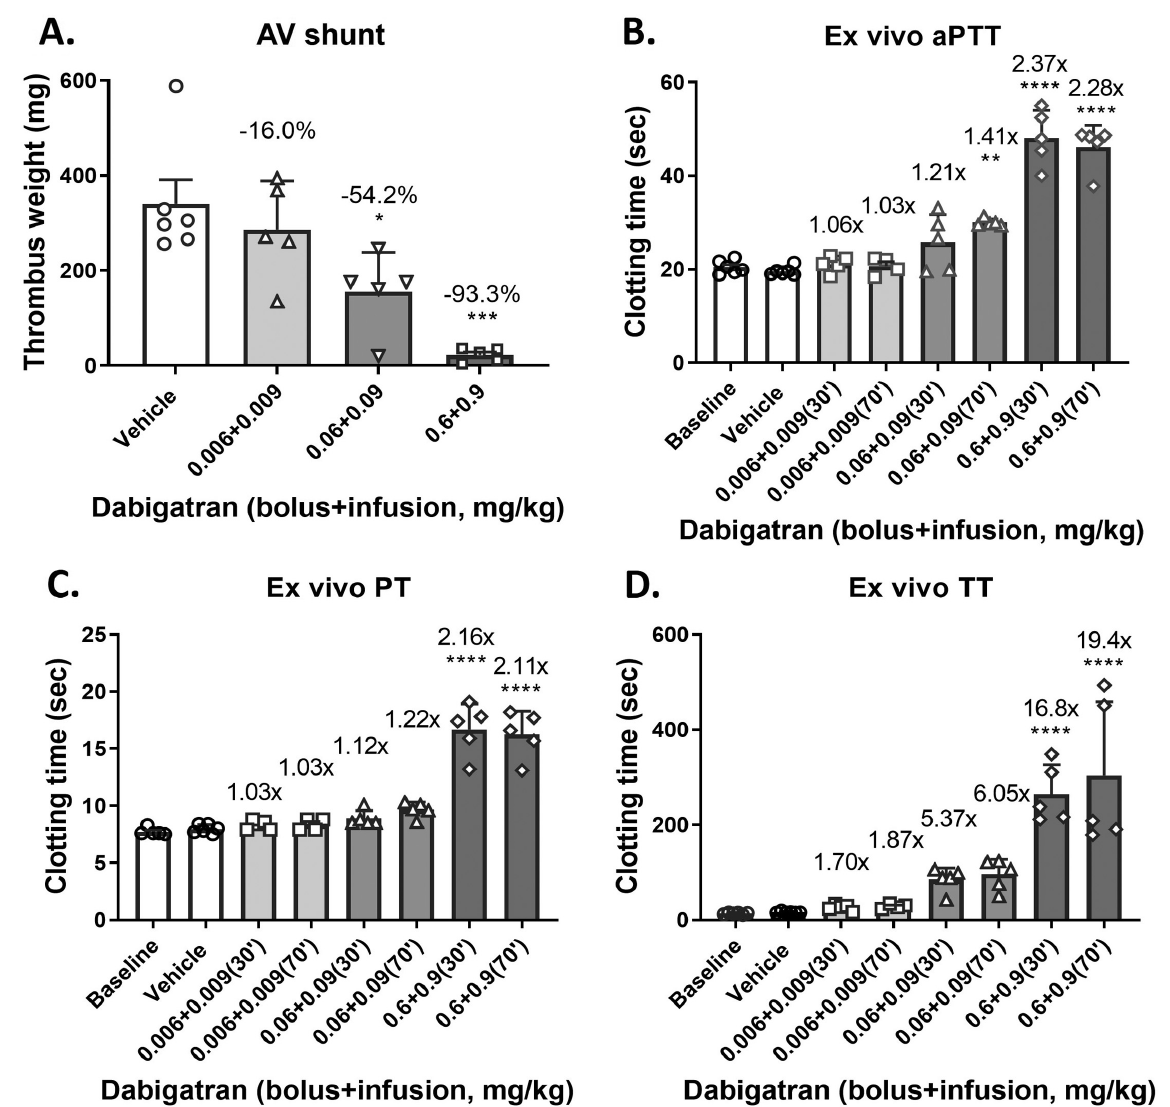
Fig. 3 Dose-dependent effects of dabigatran on thrombus formation in the rabbit arteriovenous (AV) shunt model of thrombosis and ex vivo clotting. ( A ) Dabigatran dose dependently reduced thrombus weight in the rabbit AV shunt model of thrombosis. Plasma samples were taken immediately prior to (30minutes after infusion) and after (at 70minutes) the AV shunt thrombosis and subjected to the ex vivo analysis of ( B ) activated partial thromboplastin time (aPTT), ( C ) prothrombin time (PT), and ( D ) thrombin time (TT). Each symbol in ( A ) represents 1 animal. Fold changes are indicated against vehicle in ( B ) and ( C ). (cid:4) p < 0.05. (cid:4)(cid:4) p < 0.01. (cid:4)(cid:4)(cid:4) p < 0.001. (cid:4)(cid:4)(cid:4)(cid:4) p < 0.0001. Analysis of variance (ANOVA) followed by Tukey ’ s